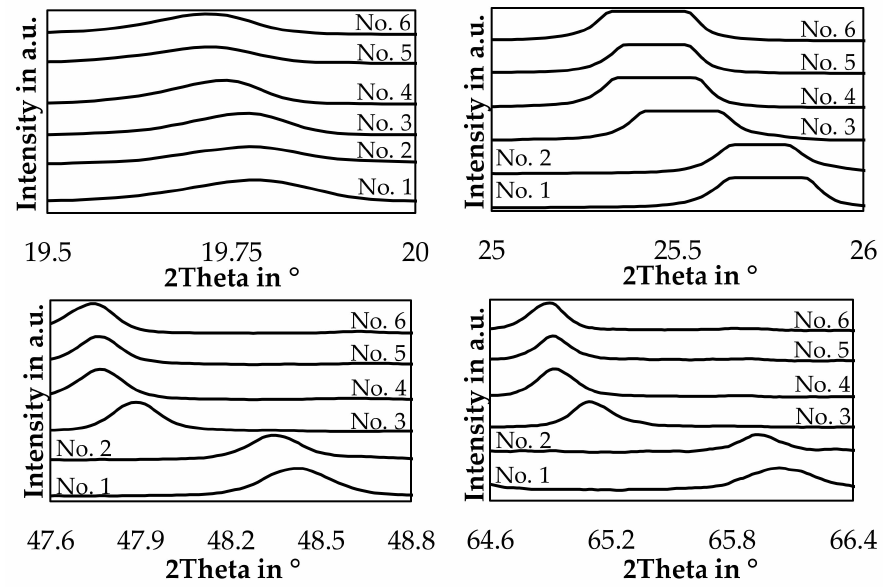
Figure 14. Detailed XRD-pattern of the four strongest β -eucryptite peaks.